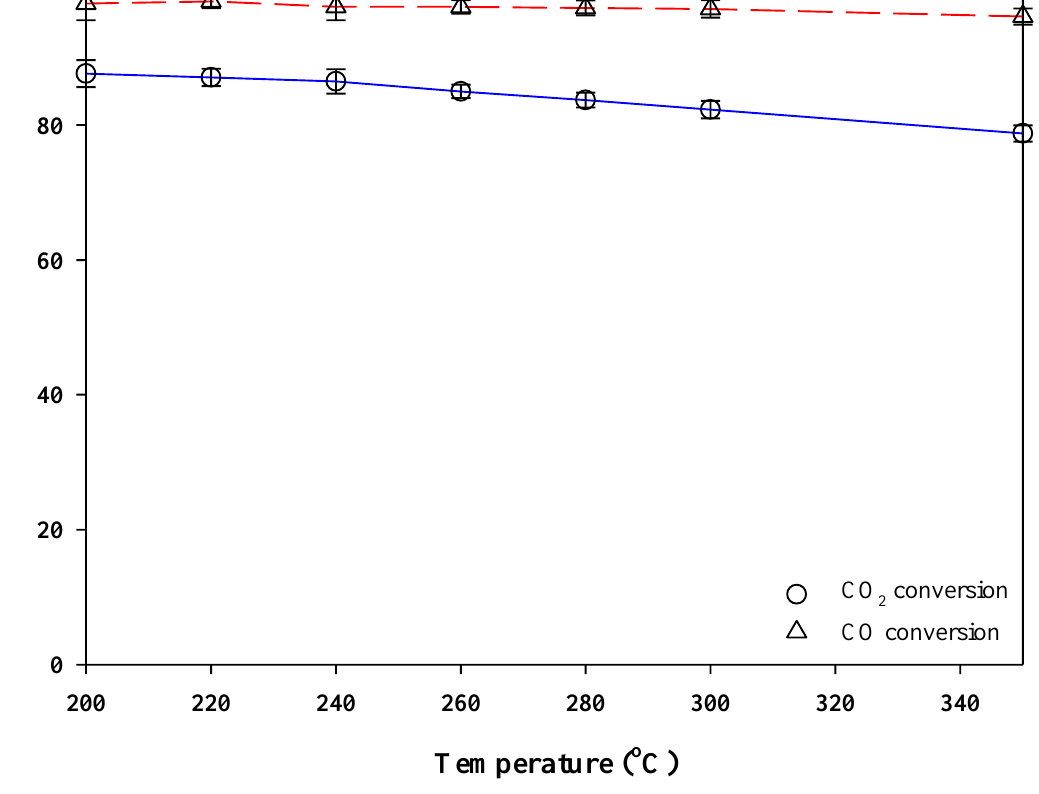
Figure 8. The concentration of the final out gases after the methanation reaction depending on reac- tion temperatures (Inlet gas ratio: H 2 :CO 2 = 4:1 to H 2 :CO = 3:1). 3.4. Result of durability test & analysis of catalysts To evaluate the durability of the catalysts, this study conducted a lifetime test when 5 – 15% CO gas coexisted during the CO 2 methanation reaction. At 300 °C as a temperature range the reaction proceeded stably which is moderate to operate in the actual process, COx methanation was observed for 24 h under each condition (Figure 9). It showed high activity and excellent stability during the 24 h COx methanation reaction.